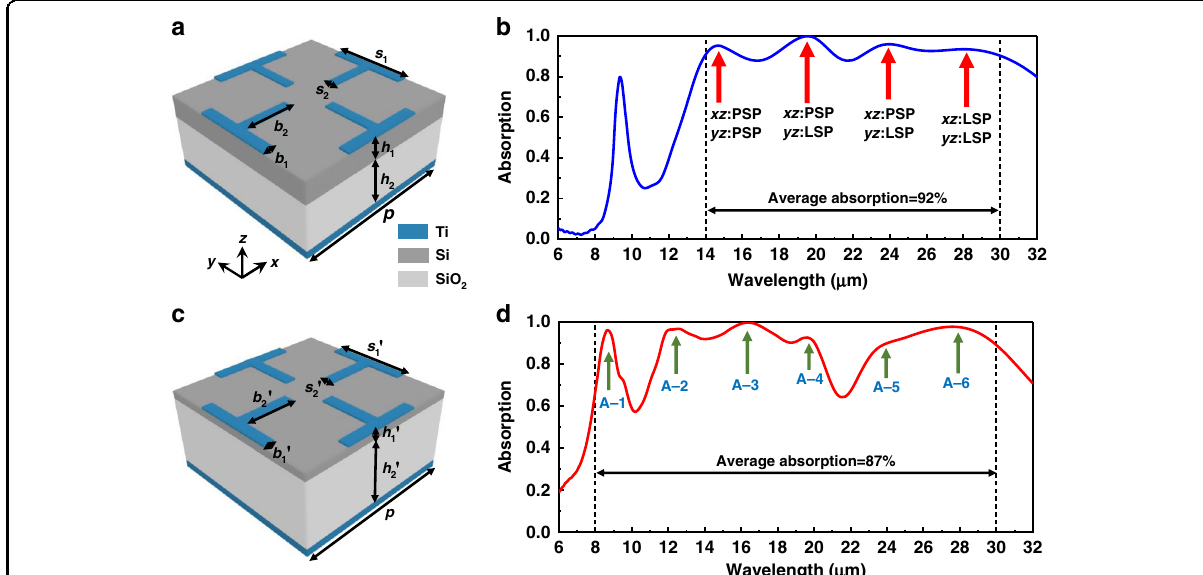
Fig. 5 Simulated absorption characteristics of two types of Ti/Si/SiO 2 /Ti absorbers from long to very long infrared regime. a Schematic and b absorption spectrum of the Ti/Si/SiO 2 /Ti absorber from 14 to 30 μ m. ( s 1 = 1.9 μ m, s 2 = 0.23 μ m, b 1 = 0.25 μ m, b 2 = 1.17 μ m, h 1 = 0.52 μ m, h 2 = 1.11 μ m and p = 4 μ m). c Schematic and d absorption spectrum of the Ti/Si/SiO 2 /Ti absorber from 8 to 30 μ m. ( s 1 ′ = 1.9 μ m, s 2 ′ = 0.27 μ m, b 1 ′ = 0.25 μ m, b 2 ′ = 1.21 μ m, h 1 ′ = 0.18 μ m and h 2 ′ = 1.62 μ m) The thickness of the top Ti layer is 22 nm and the bottom Ti layer is 120 nm, which is